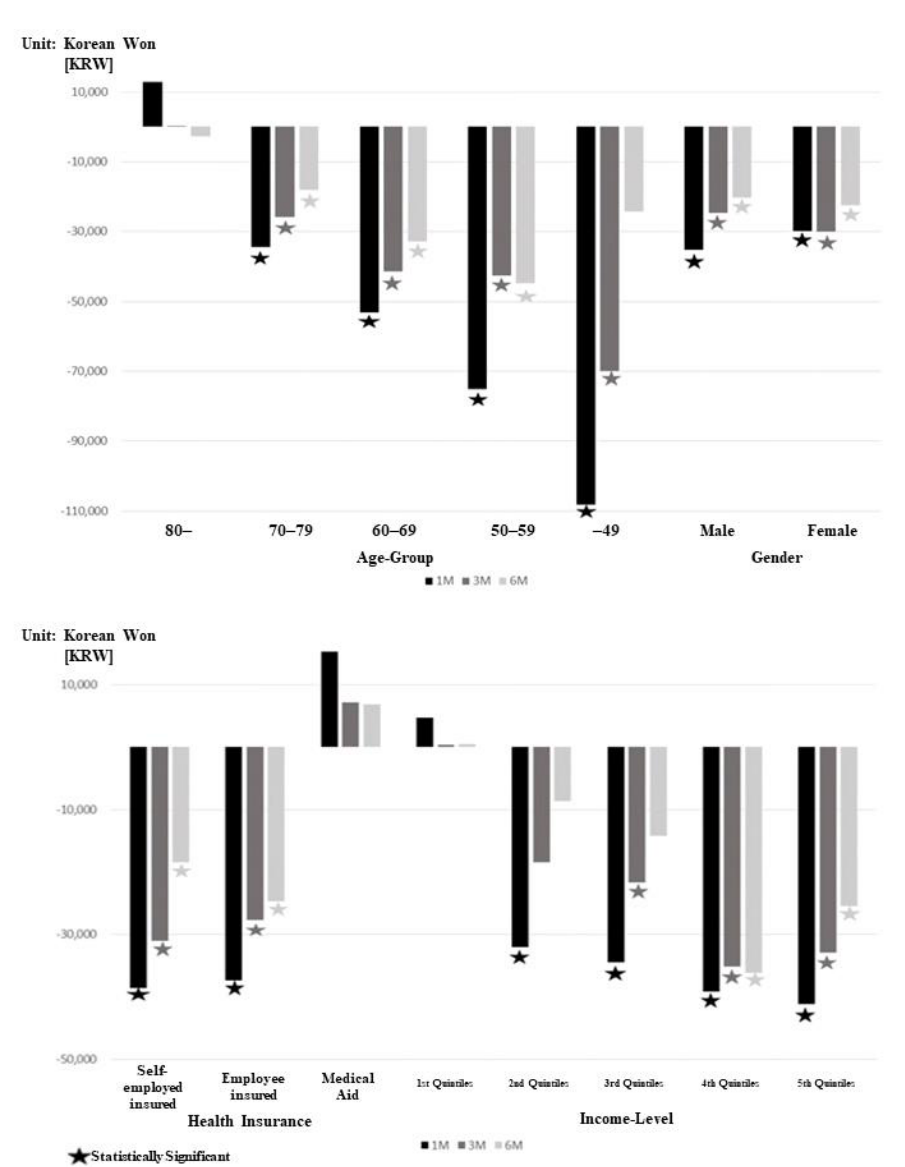
Figure 2. The result of subgroup analysis to investigate differences in hospital charges by subgroups based on the use of hospice services.